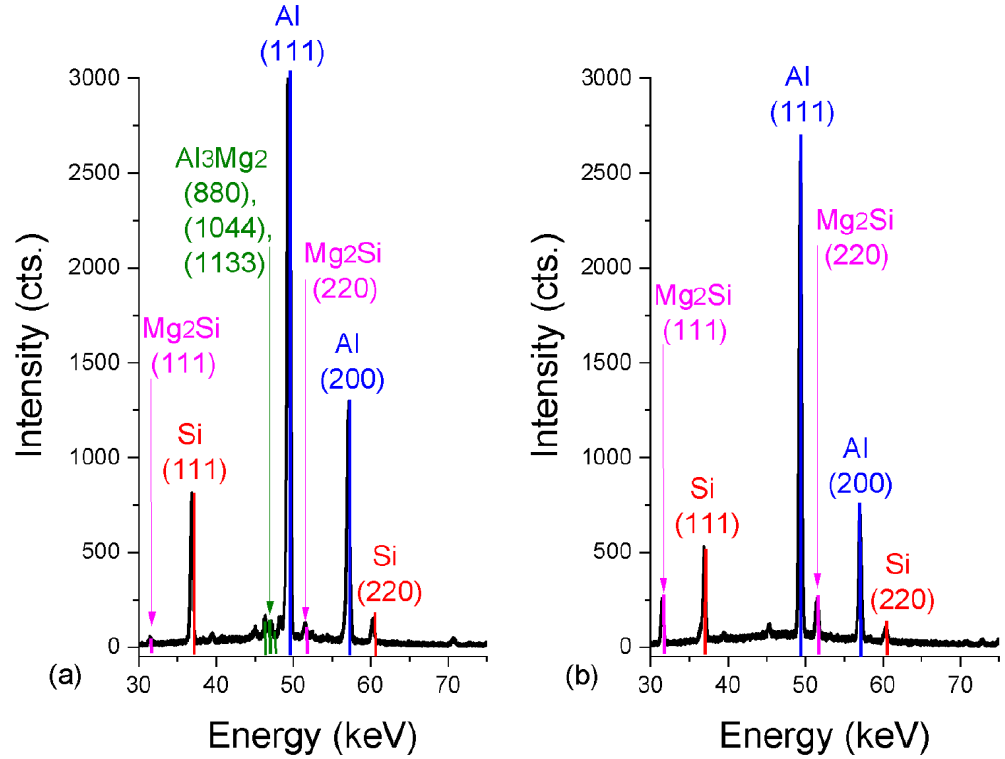
Figure D1. Diffraction pattern of an AlSi8Mg4 sample ( a ) before and ( b ) after foaming. The increase of the Mg 2 Si phase after foaming is clearly observable.